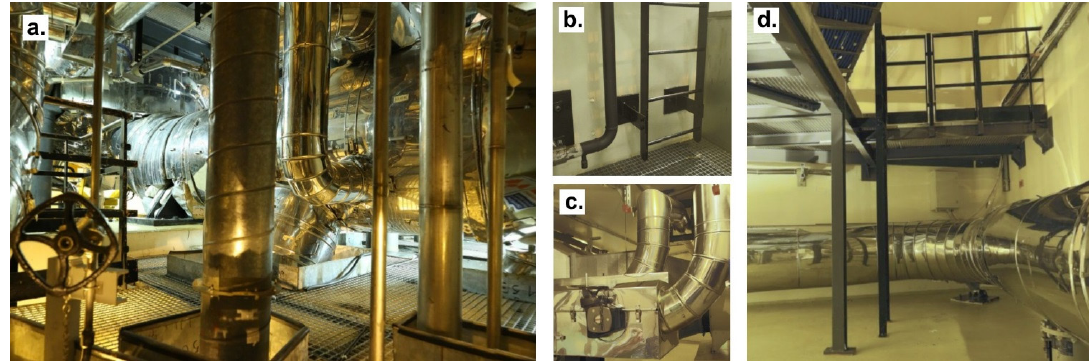
Figure 3. Specific issues of a power facility: ( a ) rooms are often very congested, ( b ) objects can be very dark and ( c ) stainless objects can be clean and then very reflective, ( d ) often coexisting in one